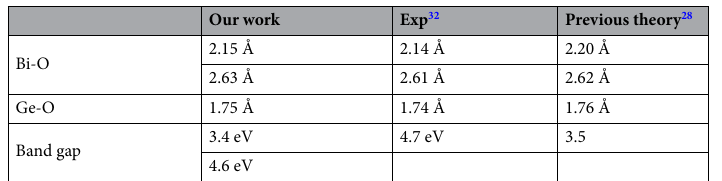
Table 1. Calculated lattice parameters and the band gaps of pristine BGO Calculated equilibrium interatomic distances (Å) in BGO, compared to the experimental data. In parenthesis is the PBE0 calculated band gap.